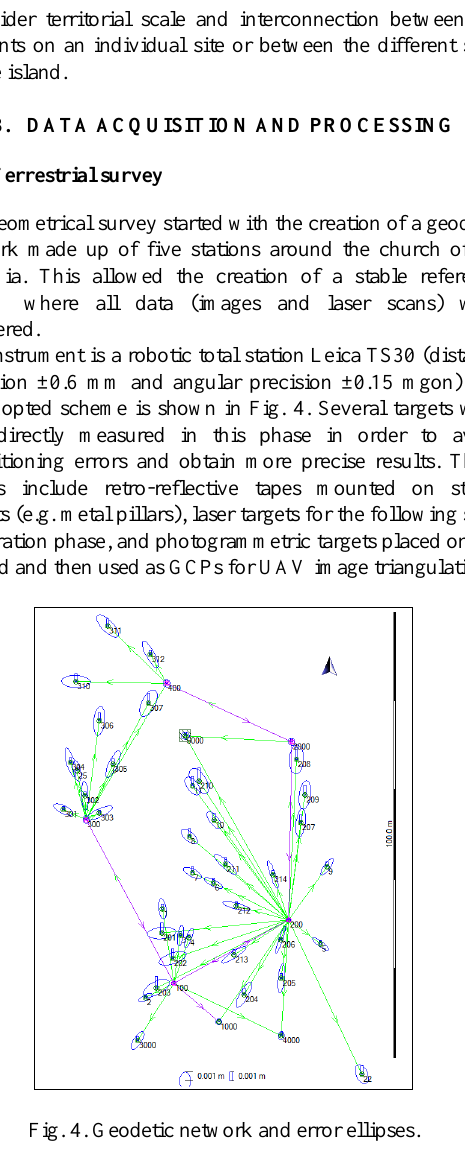
Fig. 4. Geodetic network and error ellipses.